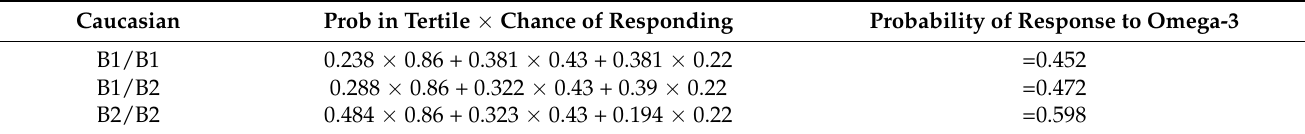
Table 3. Probability of response to omega-3 supplementation in each